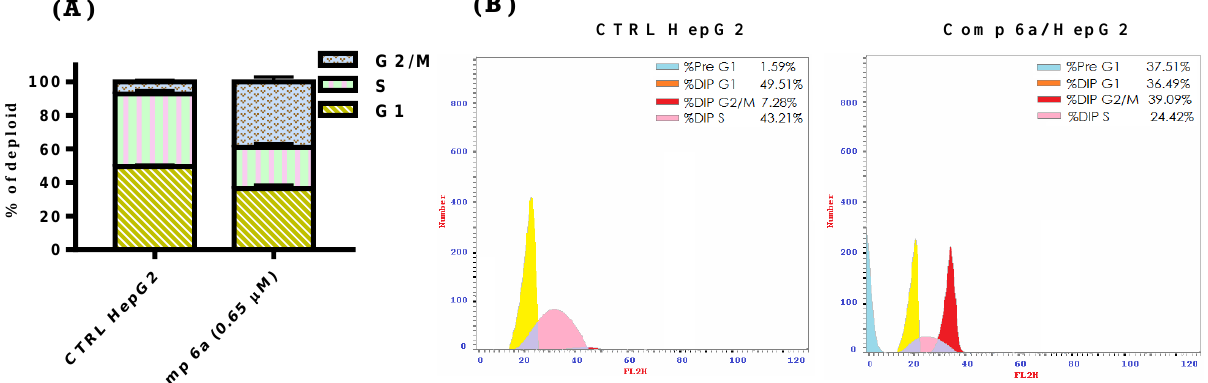
Figure 4. ( A ) Graphical representation of cell cycle analysis in HepG2 cells after 48 h of compound 6a exposure at its IC 50 concentration ( µ M) compared with the untreated control. ( B ) Cryptograms shows cell cycle analysis after 48 h of compound 6a exposure at its IC 50 concentration ( µ M) compared with the untreated control.